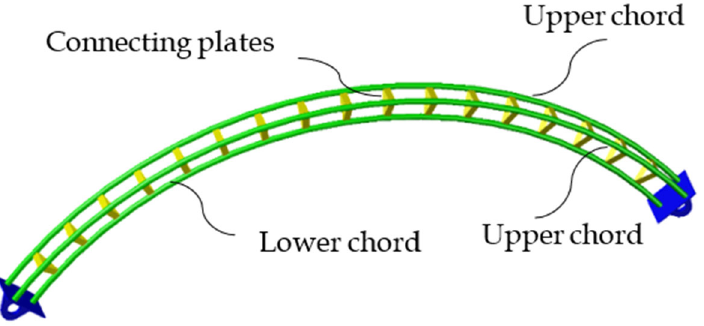
Figure 1. Three-dimensional model of plate-tube-connected circular steel arches with inverted triangular cross sections.